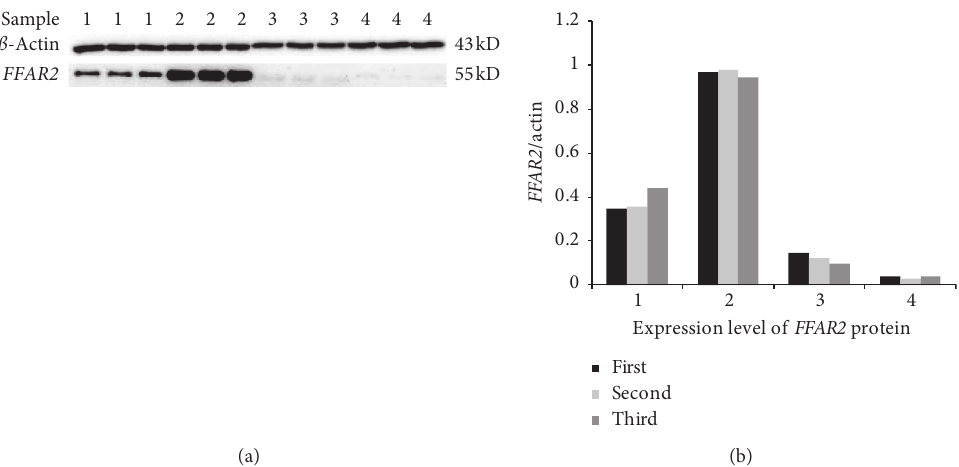
Figure 2: Expression level of FFAR2 protein. In the control group, the sample numbers are 1 and 2, and in the AMI group, the sample numbers are 3 and 4. AMI � acute myocardial infarction. Table 4: Correlation analysis of FFAR2 mRNA level with age, history of diabetes, fasting blood glucose, and HDL-C level. Group